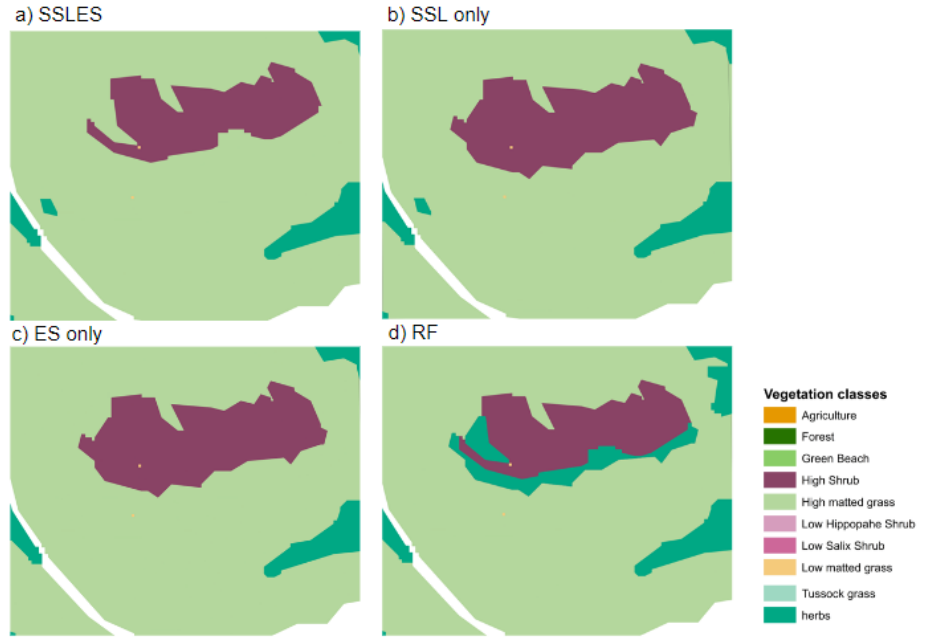
Figure 7. Example of classification result using ( a ) SSLES, ( b ) SSL only, ( c ) ES only, and ( d ) RF.